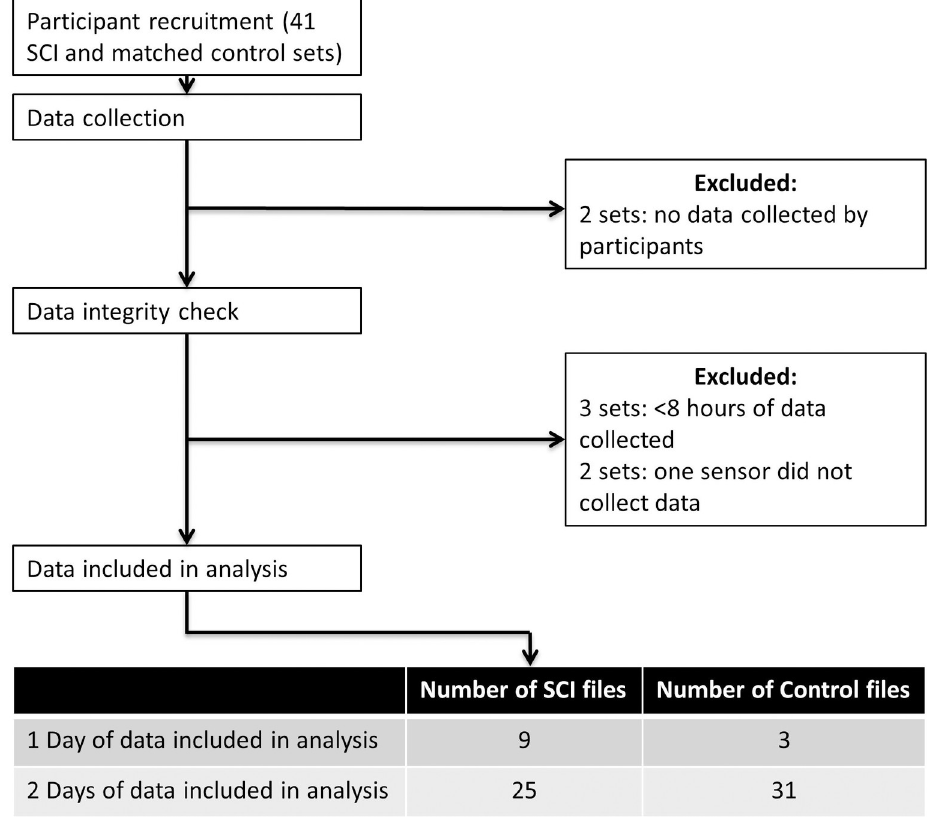
Fig 3. Data exclusion processes. Data were excluded if either SCI or control did not collect data, a minimum of 8 hours of data were not collected, or one sensor malfunctioned. Data were included in analysis if one or two days of data were